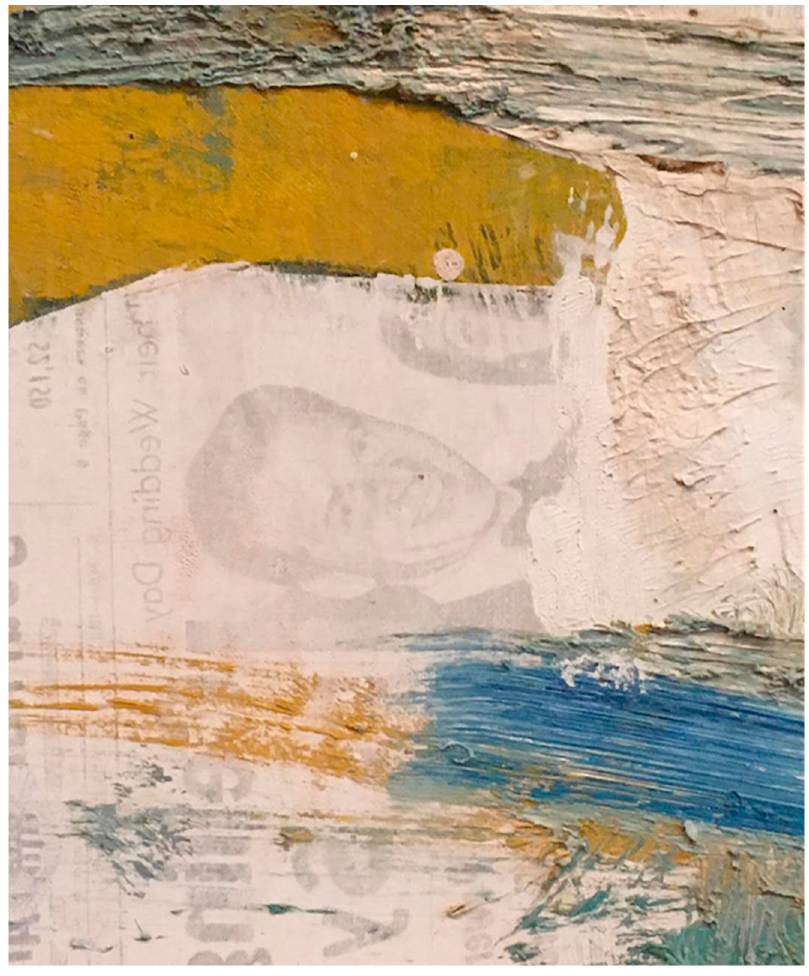
Figure 5. Easter Monday (detail).